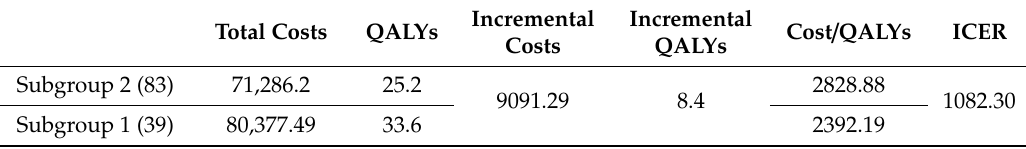
Incremental Incremental Cost / QALYs ICER Costs QALYs